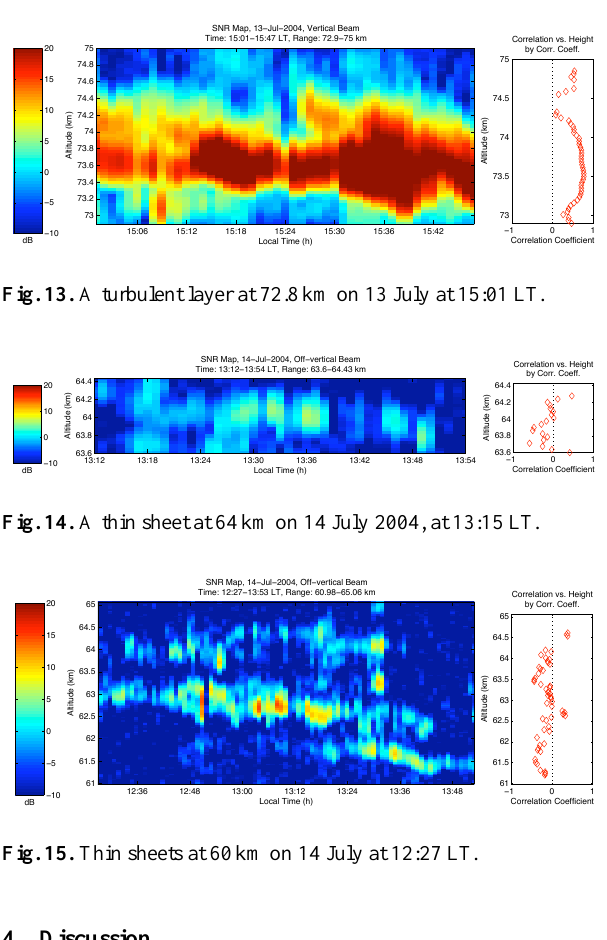
Fig. 17. Segments of meridional wind maps for May 27, 2003, (a and b) and May 28 (c).